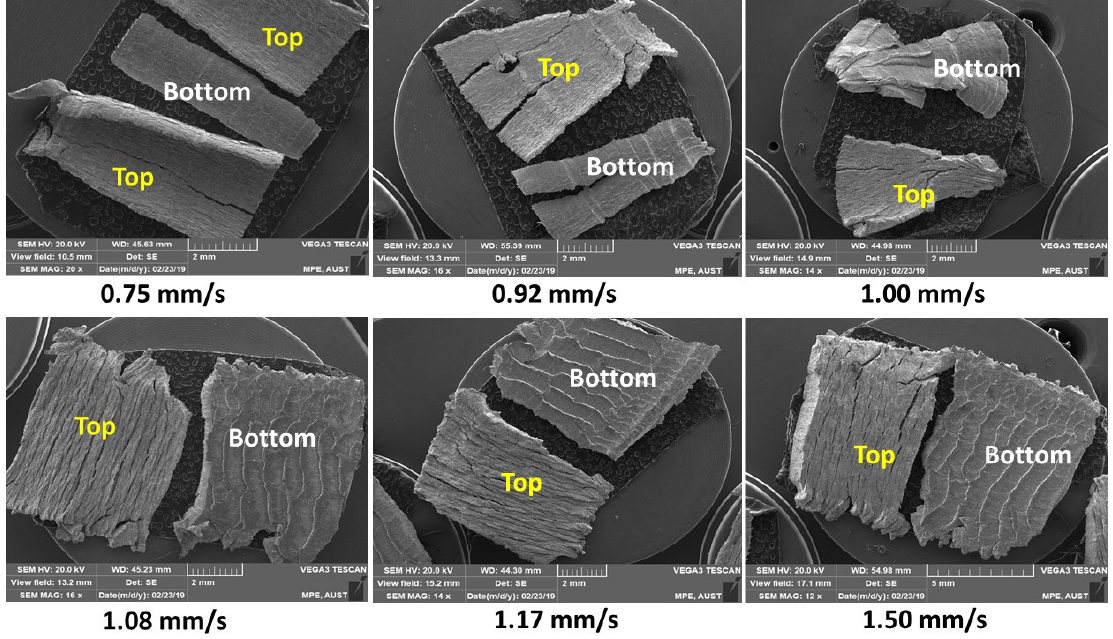
Figure 8. Effect of feed rate on macro chip formation of Al alloy.